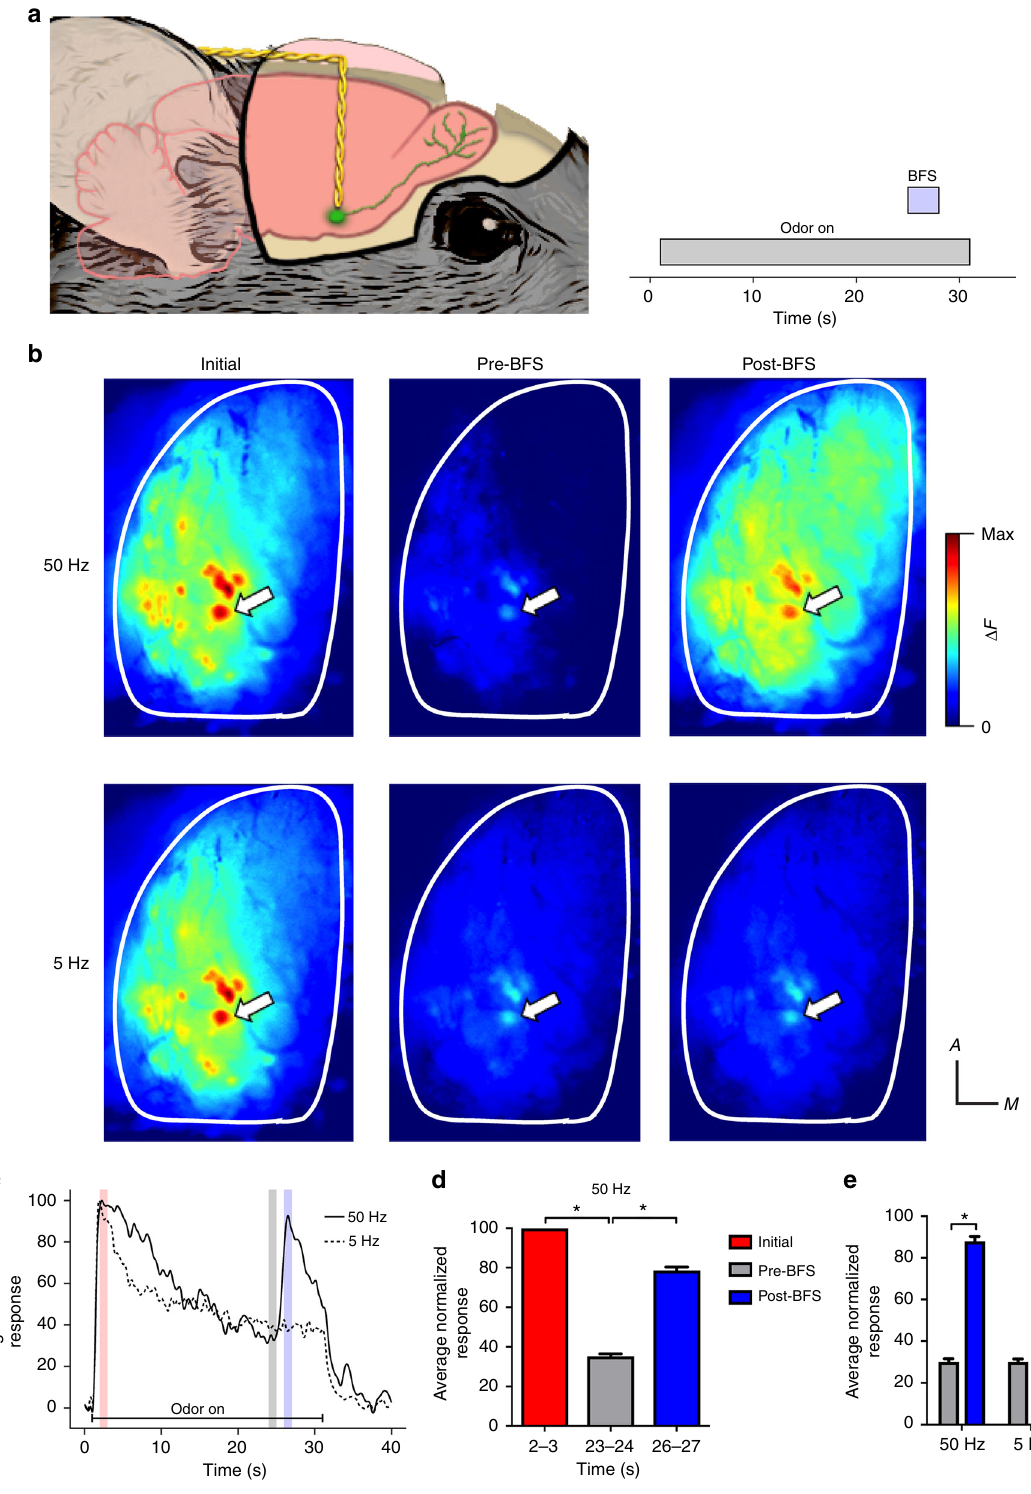
Fig. 2 Electrical basal forebrain stimulation (BFS) dishabituates glomerular odor responses in anesthetized mice. a Schematic illustration of the imaging experiment. b Pseudo-color glomerular responses to 2-heptanone (0.5% s.v.) initially and before and after BFS (50 µ A, 3 s) at 50 and 5 Hz. c Fluorescence traces (% of initial response) from the glomerulus indicated by arrows in b . d The average glomerular odor response (% of initial response ± s.e.m) decreases during the odor presentation and increases following 50 Hz BFS ( n = 76, 5 mice). e In a subset of mice, 5 Hz stimulation was given in addition to 50 Hz, and it did not increase the average glomerular odor response. * p < 0.05. Illustration by